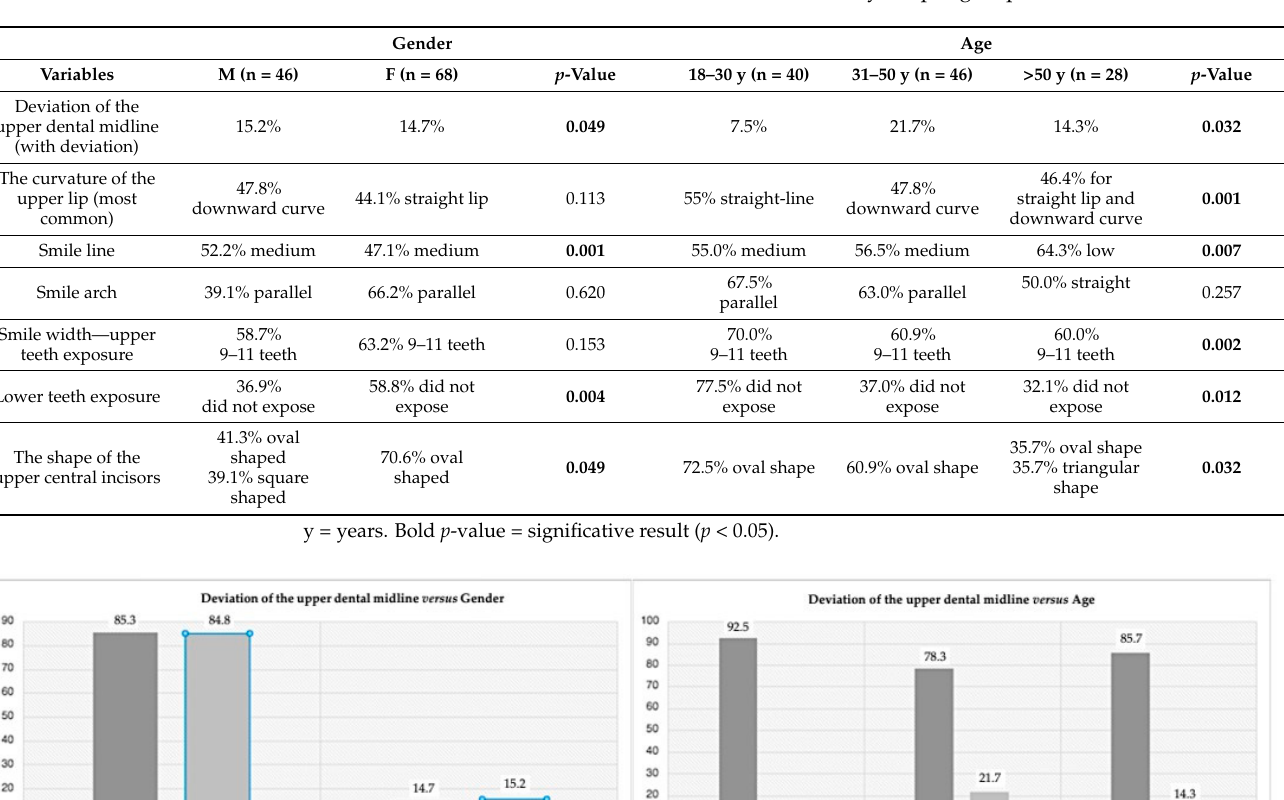
Table 2. Predominant values found for the variables analyzed per group.